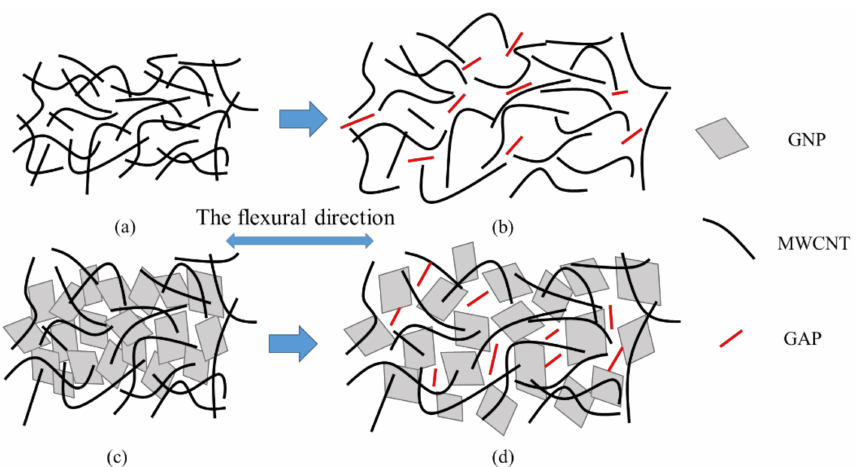
Figure 9. Schematic representation of microstructure changes in hybrid films subjected to mechanical strain. ( a ) MWCNT film; ( b ) Stretching of MWCNT film under flexural strain; ( c ) MWCNT/GNP hybrid film; ( d ) Stretching of MWCNT/GNP hybrid film under flexural strain.